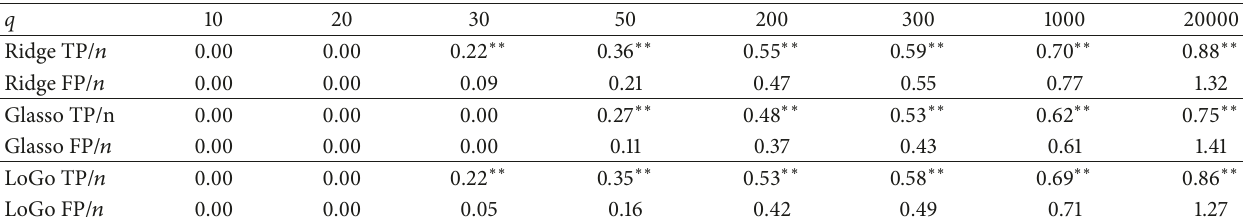
Table5: Causalitynetworkvalidationwithunconditionaltransferentropyvalidationat1 % Bonberroniadjusted 𝑝 value .Fractionoftruepositive (TP /𝑛 ) and fraction of false positive (FP /𝑛 ), statistically validated, causality links for the three models, and different time-series lengths. The table reports only the case for the parameter 𝛾 = 0.1